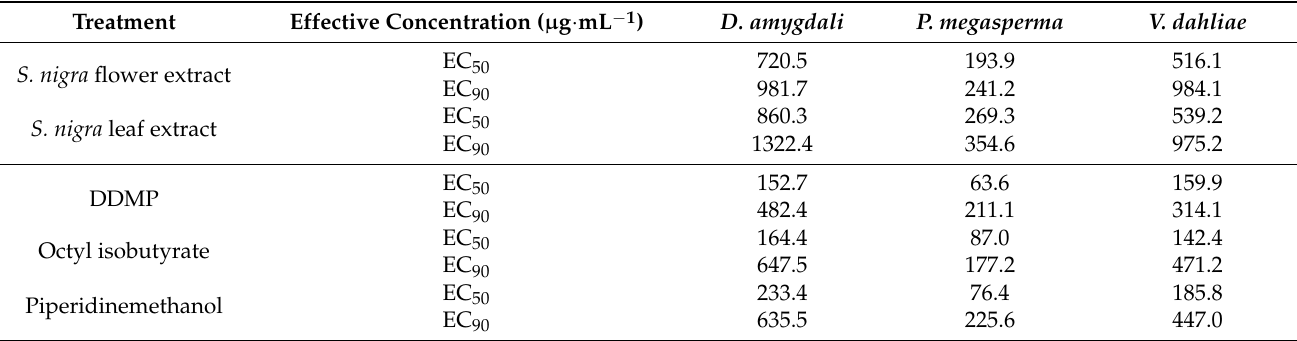
Figure 3. Some of the main phytochemicals identified in S. nigra flower aqueous ammonia extract. Table 2 summarizes the effective concentrations (EC 50 and EC 90 ) obtained for the two extracts and each of the pure compounds against each pathogen. Table 2. Effective concentrations (expressed in µ g · mL − 1 ) against D. amygdali , P. megasperma , and V. dahliae of S. nigra flower and leaf aqueous ammonia extracts, together with those of three of the main constituents of the flower